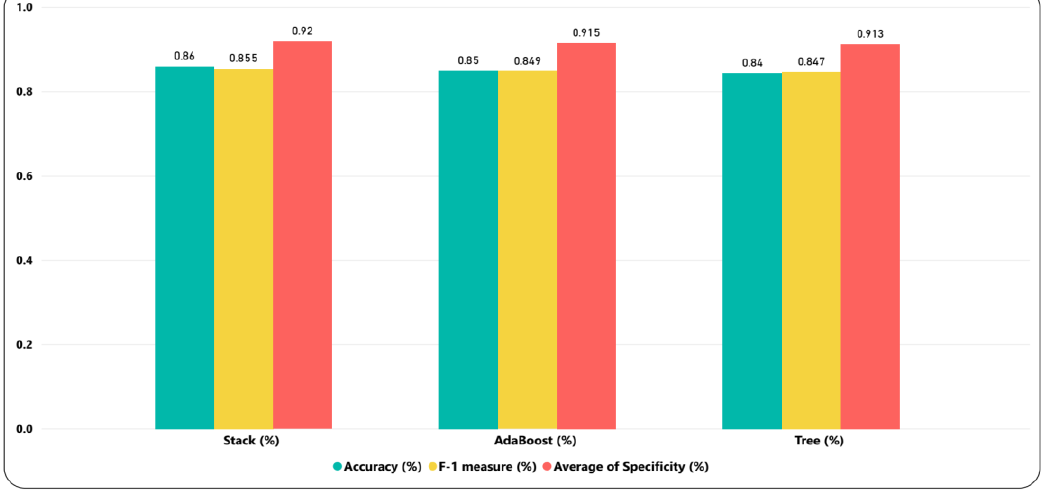
Figure 7. Runtime (seconds) with log loss comparison for different models. 6.2. Proposed Mitigation Strategies In this section, several potential mitigations strategies have been proposed to reduce the burden of traffic violations and to ensure smooth, safe, and efficient traffic operations in the study area. For red-light violations, appropriate countermeasures include installation of enforcement cameras at urban intersections, provision of signal ahead sign, installation of traverse rumble strips, activation of advance warning flashers, and improved pavement surface conditions. Previous studies indicate that most of these proposed countermeasures were very effective to limit red-light violations in urban metropolitan areas around the world [66,67]. Safety education and awareness programs could also significantly improve road safety situations [68] and should be practiced more frequently. In this regard, a comprehensive pedestrian awareness program and the establishment of pedestrian safety as a priority area must be taken to avoid pedestrian crossing violations. Various speed and traffic calming measures may be installed at violation hotpots to ensure the obeyance of traffic rules and regulations. For example, to discourage over-speeding along busy residential streets, a few mitigation measures that could be useful include the installation of speed cameras to arrest absconders, provision of speed humps, proactive traffic forecasting, and various other automated enforcement Intelligent Transport System (ITS )programs [69,70].